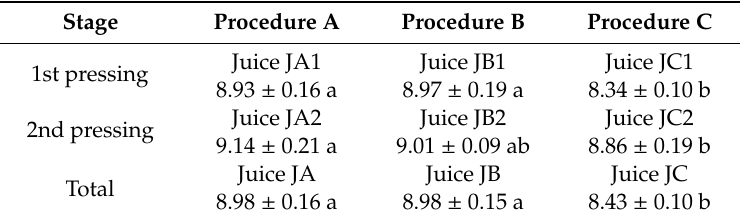
Table 1. Extract content ( ◦ Bx) of juice from celeriac root pulp according to the selected procedure and pressing stage. Abbreviations, as in Figure 3.